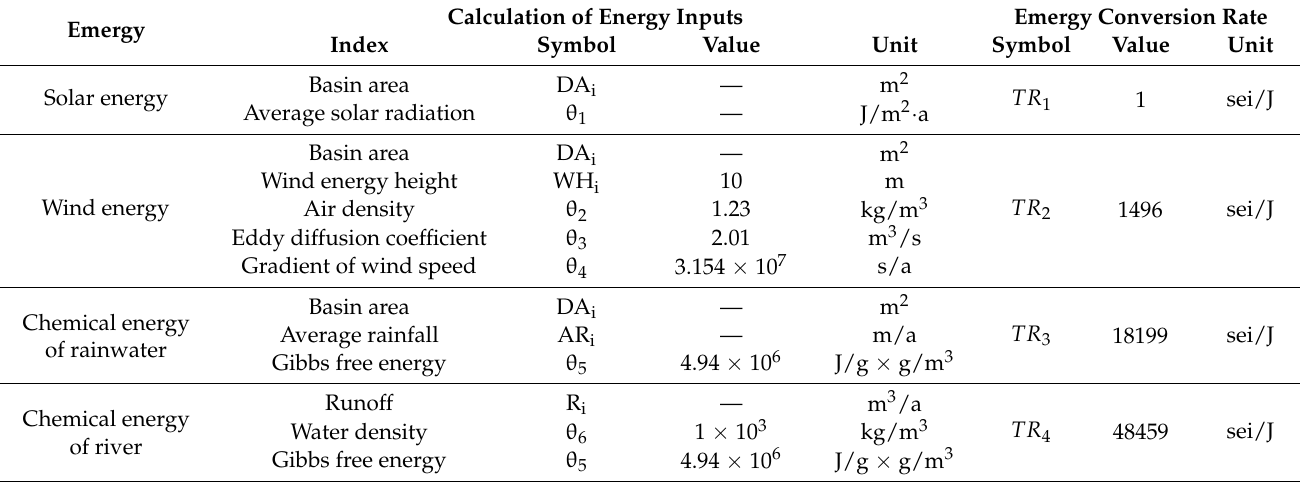
Table 2. Emergy index parameters of trans-boundary river basin (TBRB) ecosystem.